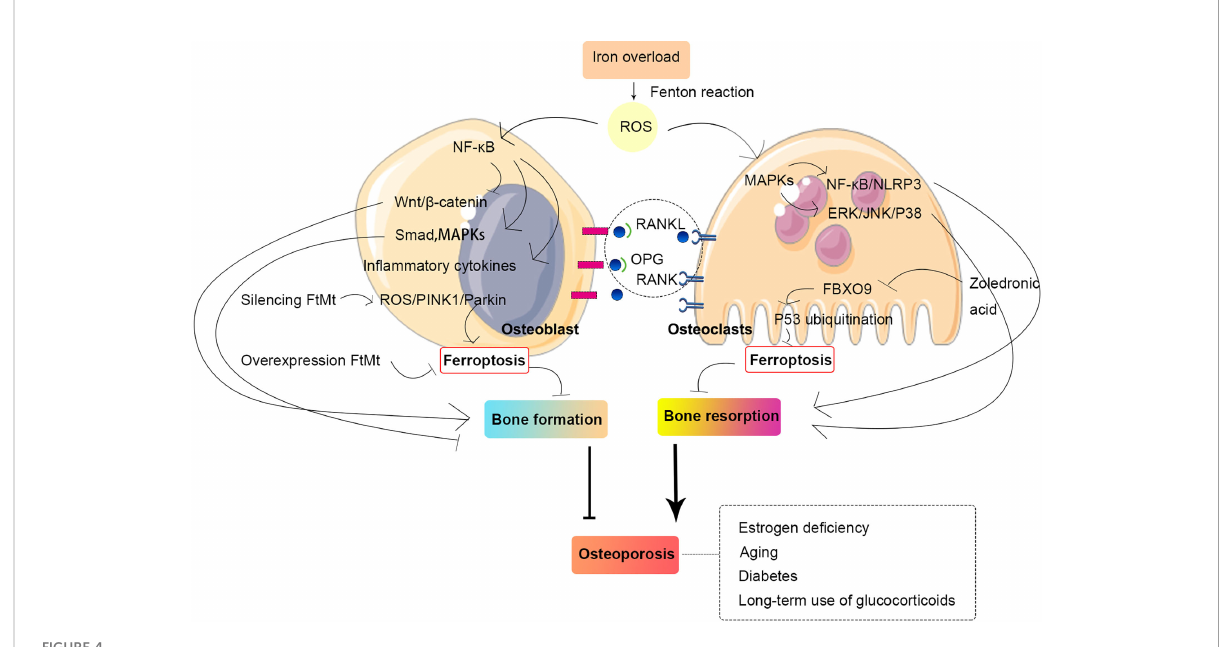
FIGURE 4 Relationship between osteoporosis and ferroptosis in osteoblast and osteoclast. The homeostasis and integrity of bone tissue require a balance between osteoclast and osteoblast activity. Iron overload can generate ROS through the Fenton reaction, and ROS can activate multiple intracellular signaling pathways, which, in turn, promote bone resorption and inhibit bone formation, thus leading to osteoporosis. Abbreviations: MAPK, mitogen-activated protein kinase; NF- k B, nuclear factor-kappa B; FtMt, mitochondrial ferritin; PINK1, PTEN-induced kinase 1; ROS, reactive oxygen species; OPG, osteoprotegerin; RANKL, receptor activator for nuclear factor- k B ligand; RANK, receptor activator for nuclear Factor- k B; NLRP3, NOD-like receptor family pyrin domain containing 3; ERK, extracellular signal – regulated kinase; JNK, c-Jun N- terminal kinase; FBXO9, F-box only protein